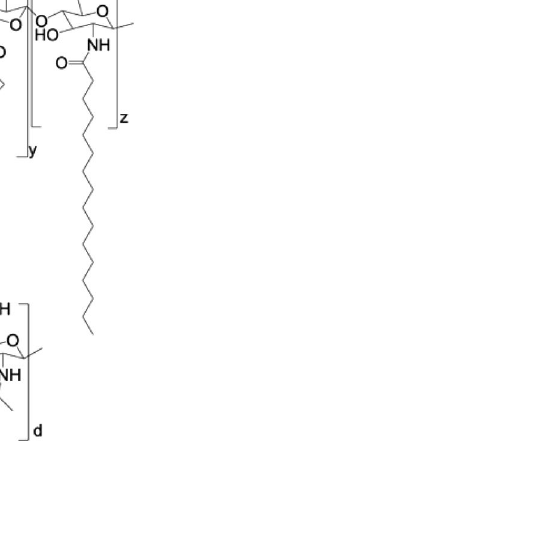
Figure 1. GCPQ and